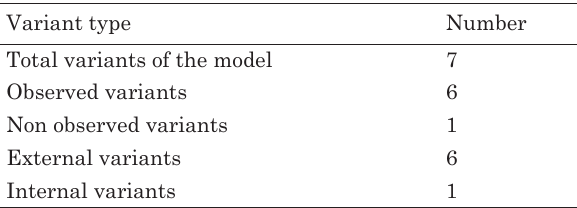
Table 9. Research types of variables (efficiency of land